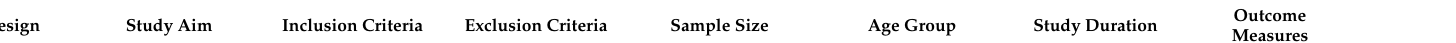
Table 5. The main characteristics of the included